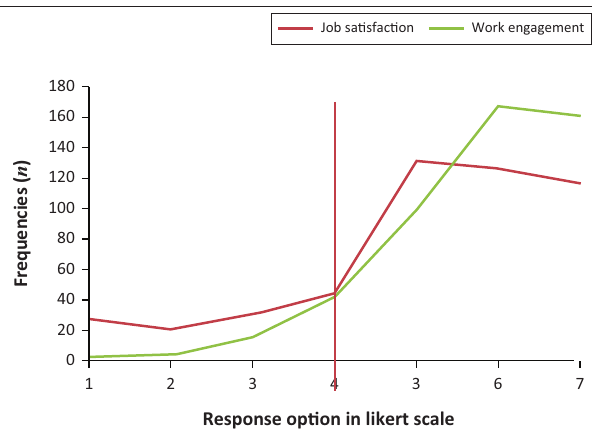
FIGURE 2: Frequency polygon for job satisfaction and work engagement at National Treasury.